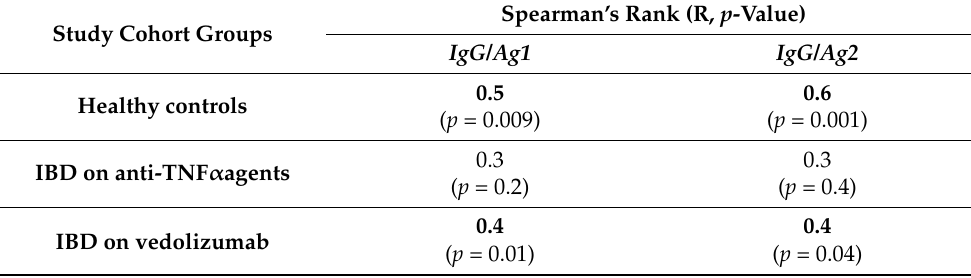
Table 2. Spearman rank correlation coefficient (R) and significance ( p -value) between humoral and cellular immune response for Ag1 and Ag2 peptide pool. Significant correlations ( p -value < 0.05) are indicated in bold.